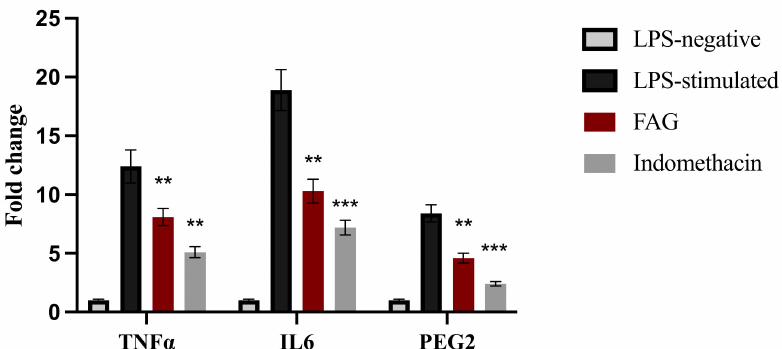
Figure 5. Expression of TNF- α , IL-6 , and PGE2 genes as determined by quantitative real-time PCR. Genes expression was normalized to the corresponding GAPDH gene expression and expressed relative to that of LPS-untreated RAW 264.7 cells. Indomethacin was used as a positive control. Bars represent mean ± SD. Significant difference was analyzed by one-way ANOVA. Where **; p < 0.01, ***; p < 0.001, compared to LPS-stimulated RAW 264.7 cells.